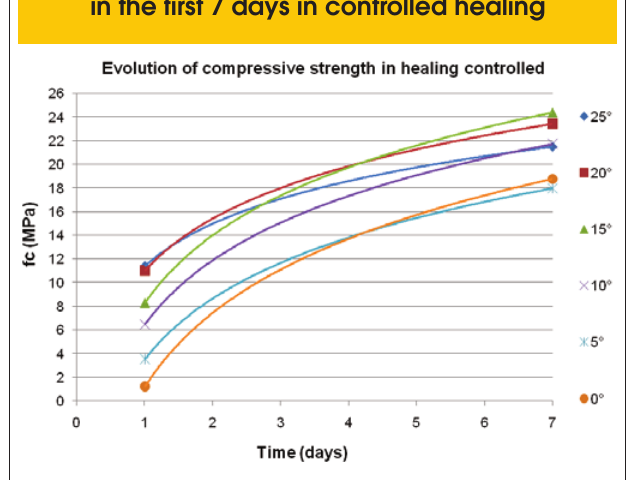
Figure 1 – Evolution of compressive strength in the first 7 days in controlled